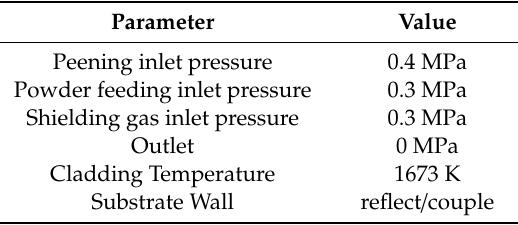
Figure 3. The mesh generation diagram. Table 2. The initial boundary conditions of the model.